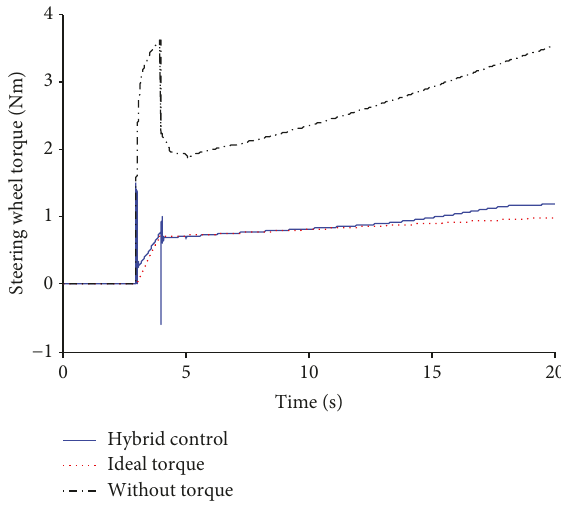
Figure 19: Comparison of steering wheel torque.